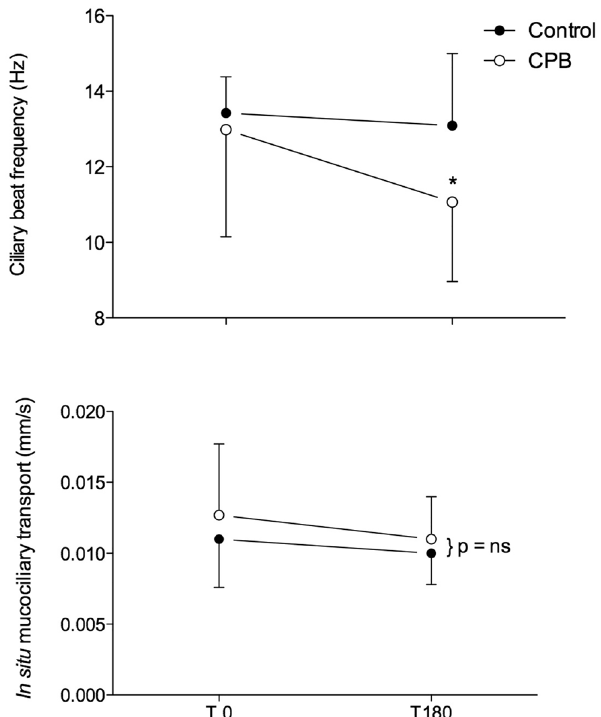
means different from baseline (p < 0.05). Data expressed as the means ± SD.